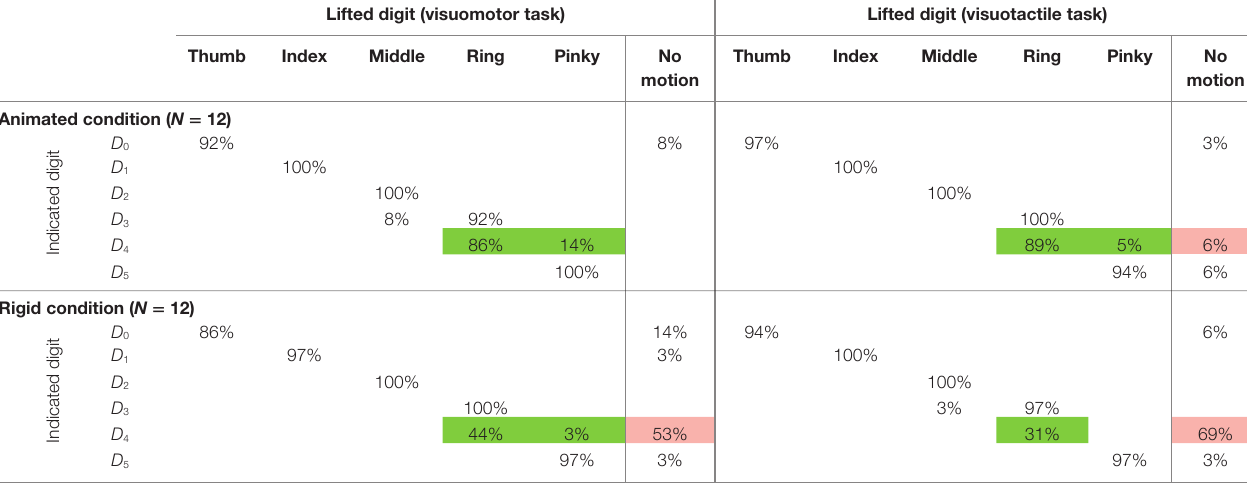
TaBle 2 | confusion matrix between indicated virtual digit and lifted real digit, for each Task and Group